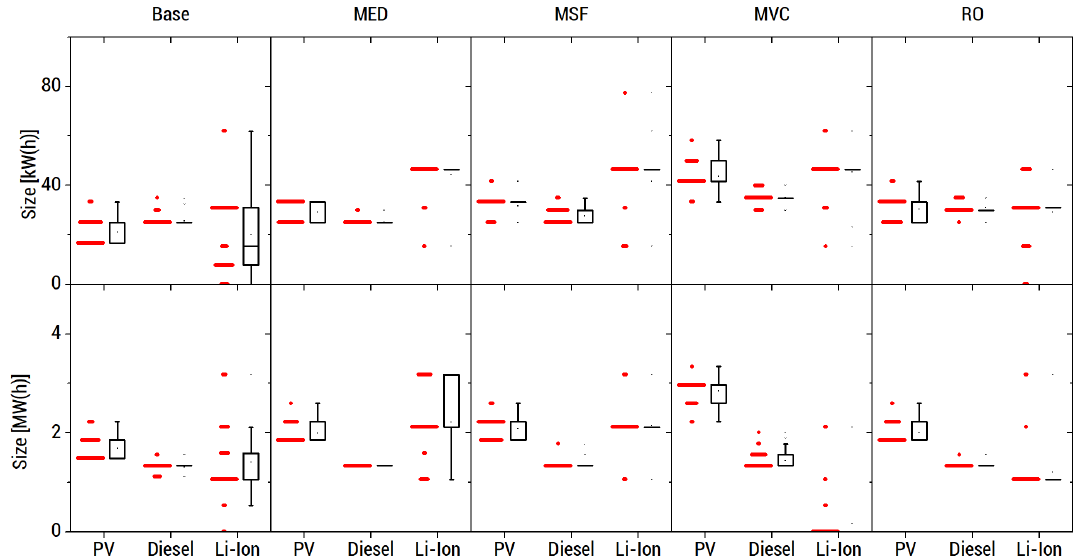
Figure 15. Distribution of optimum sizes of energy components on Camasusu Island ( top ) and Lubang Island ( bottom ) at − 25% overnight fuel price.